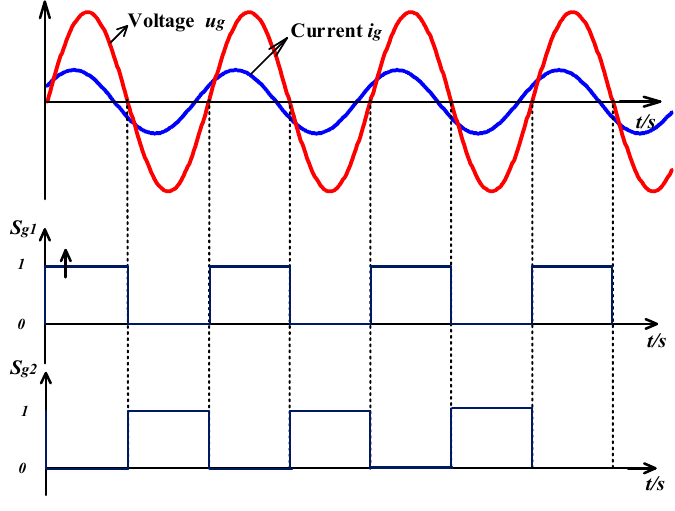
Figure 4. The front-end stage AC/DC converter operates at the line frequency.